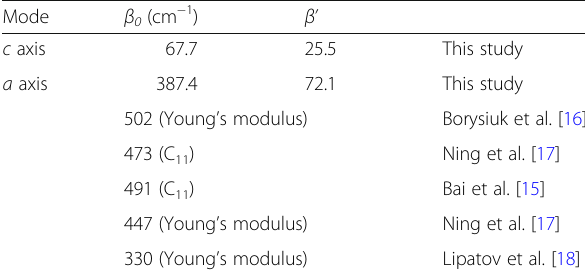
Table 1 The first and second order compression coefficients of Ti 3 C 2 T x , which are calculated by fitting Fig. 2b through Eq. 1